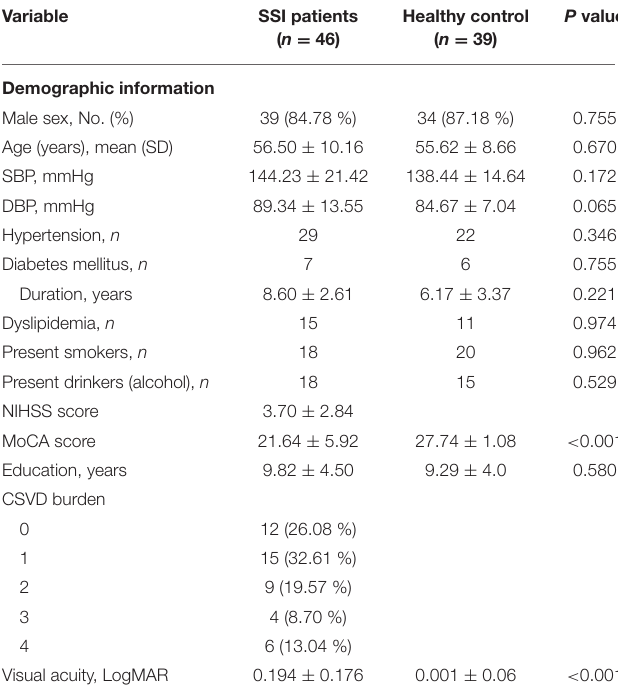
TABLE 1 | Demographic and clinical information of study participants.